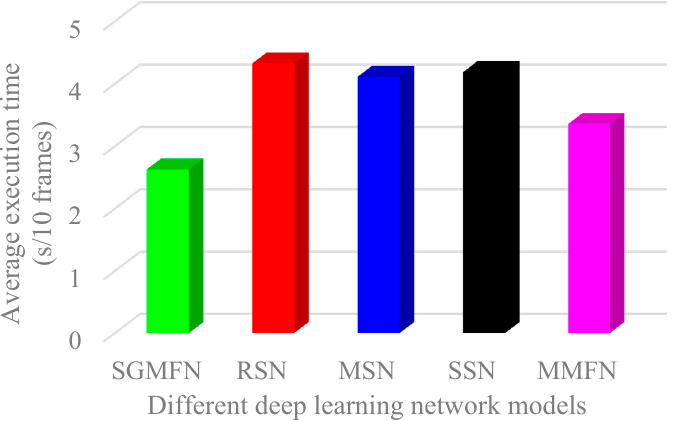
Figure 13. Comparison results of average execution time of different network models.